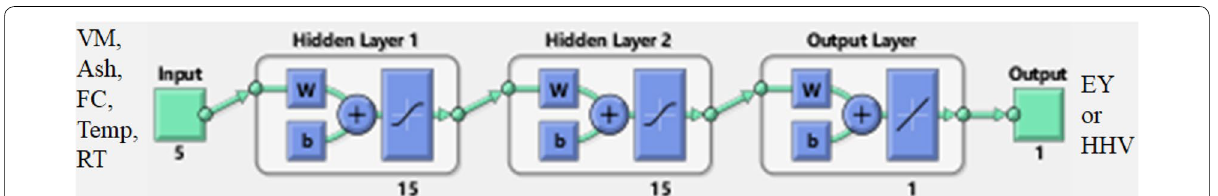
Fig. 7 Optimum MISO-ANN architecture for either EY or HHV (5–15-15–1)